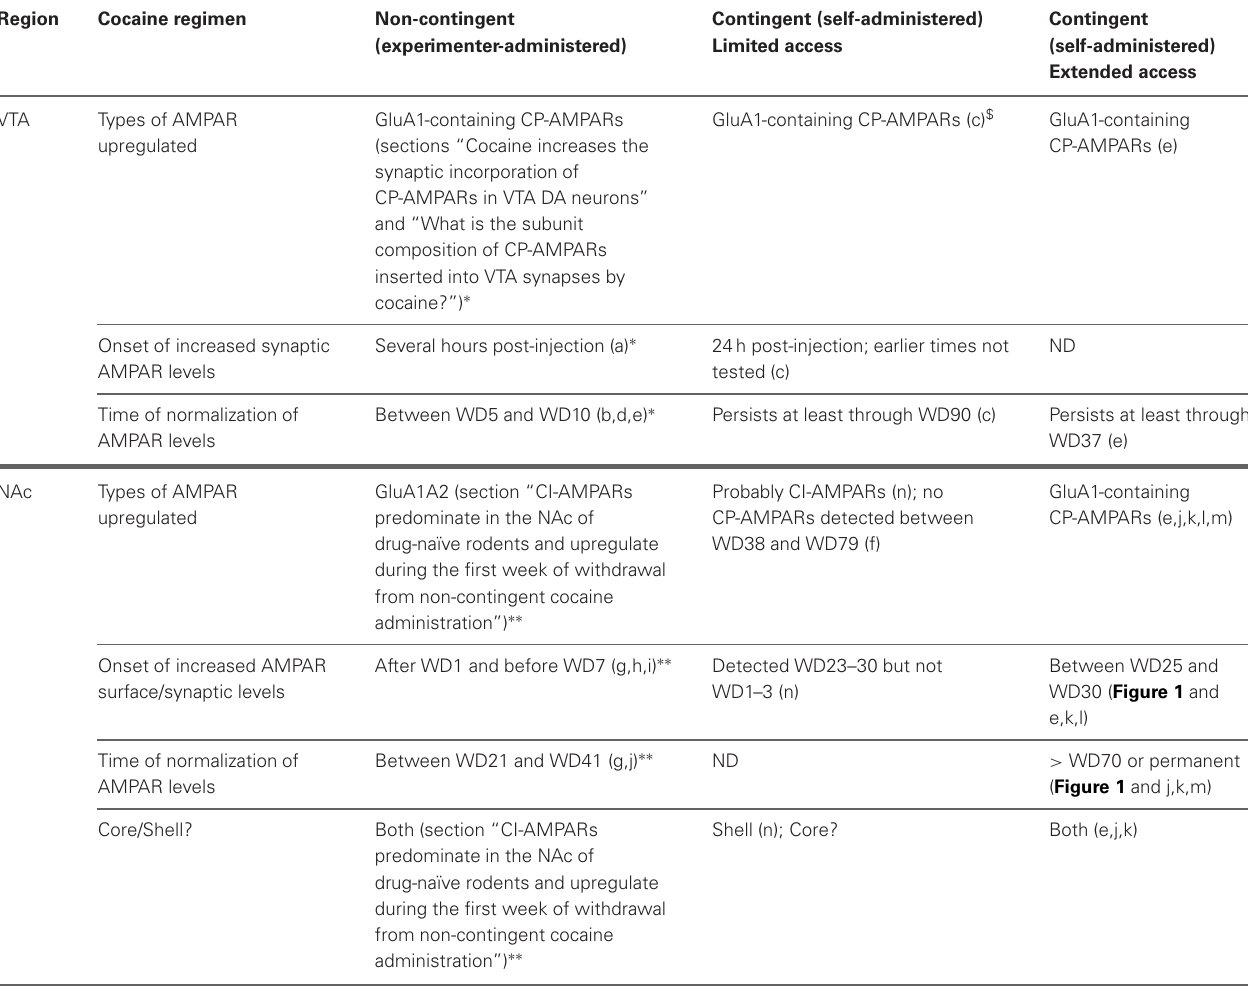
Table 1 | Summary of AMPAR changes in VTA and NAc after different cocaine